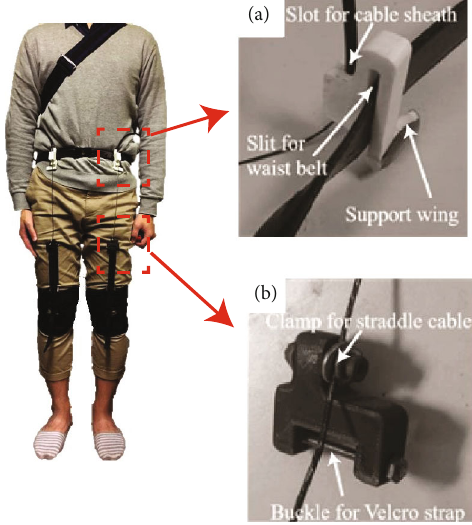
Figure 9: (a) Anchors and (b) connectors mounted on the